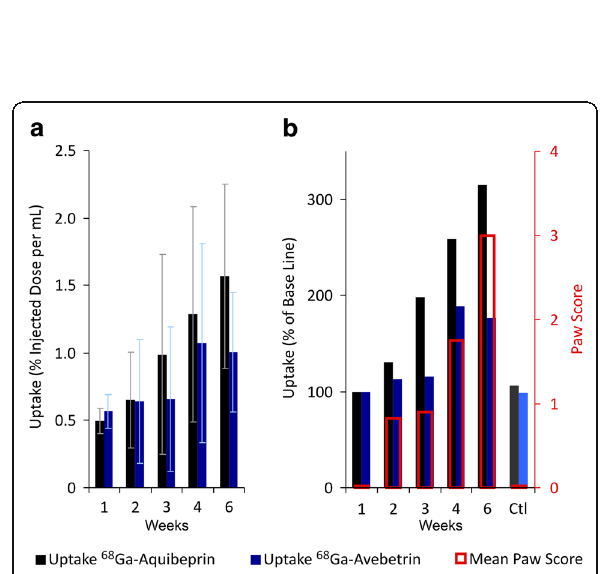
Fig. 5 Growth of integrin PET signals over time and correlation with clinical RA indicators. a Uptake of 68Ga-Aquibeprin and 68 Ga- Avebetrin in the arthritic ankles and knees (mean ± SD, n = 24), derived from PET data by an analysis of regions of interest (ROI). b Normalized uptakes (week 1 = 100%) and mean paw scores at the time of imaging. Error bars omitted for clarity; for data with error bars, see Fig. 1a and Fig. 5a. Ctl: data for non-arthritic mice at